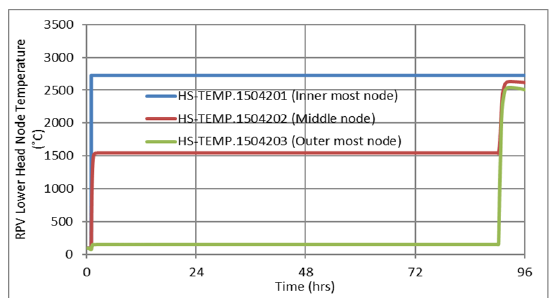
Fig. 7: MELCOR temperature profiles of internal, middle and external nodes for constant temperature sources